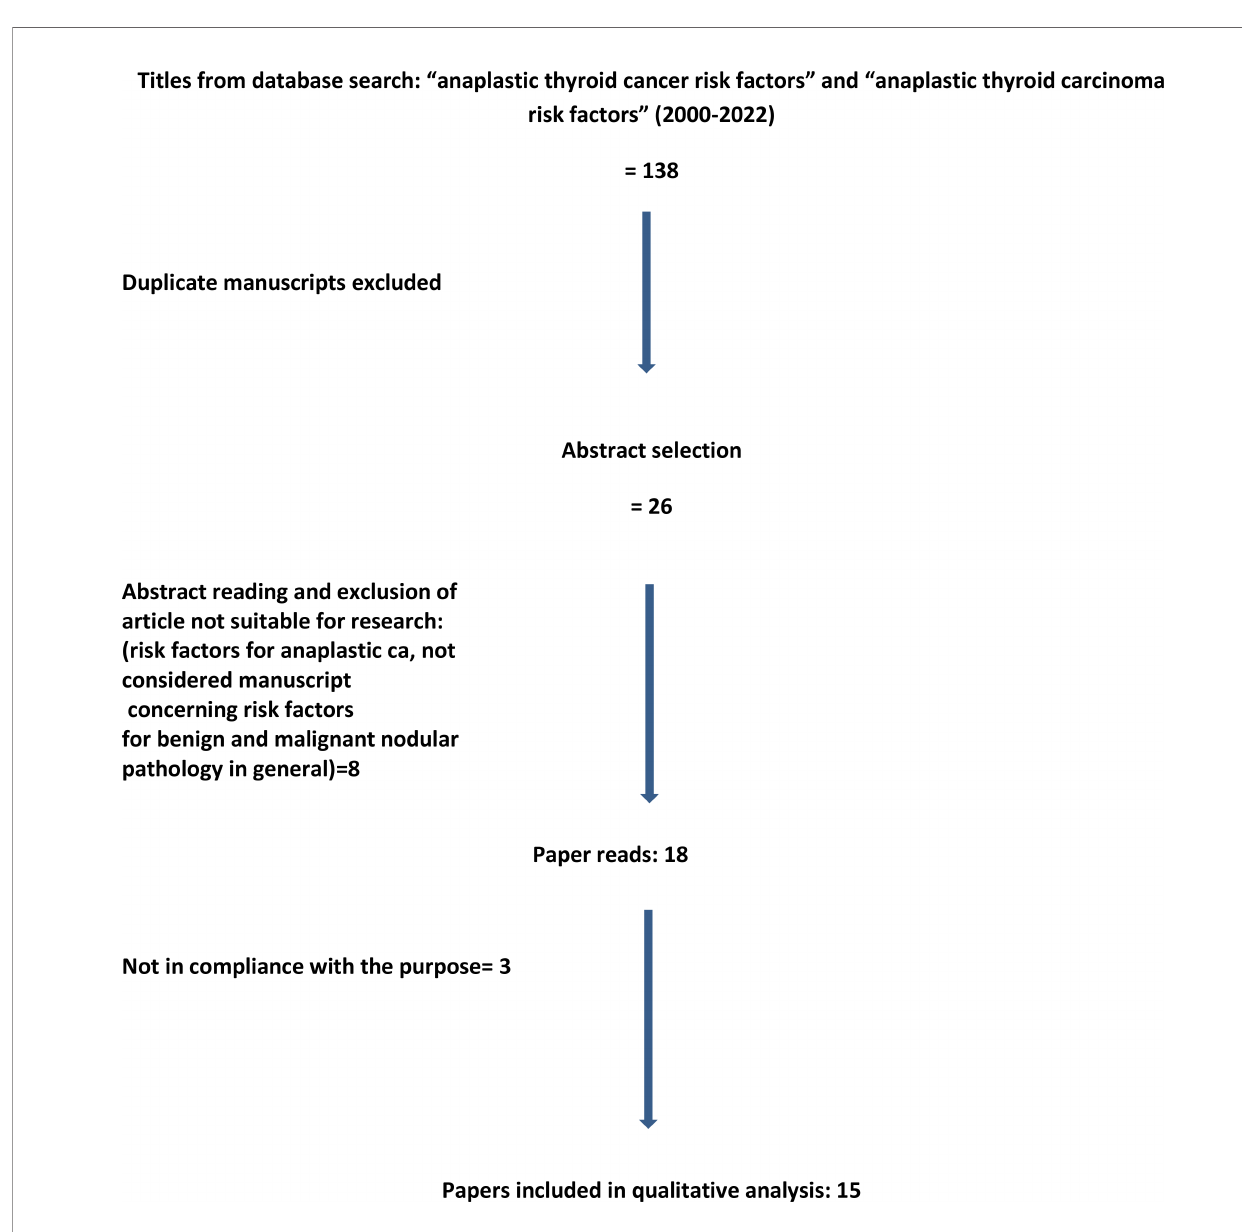
FIGURE 1 | Prisma diagram detailing the literature search process and article